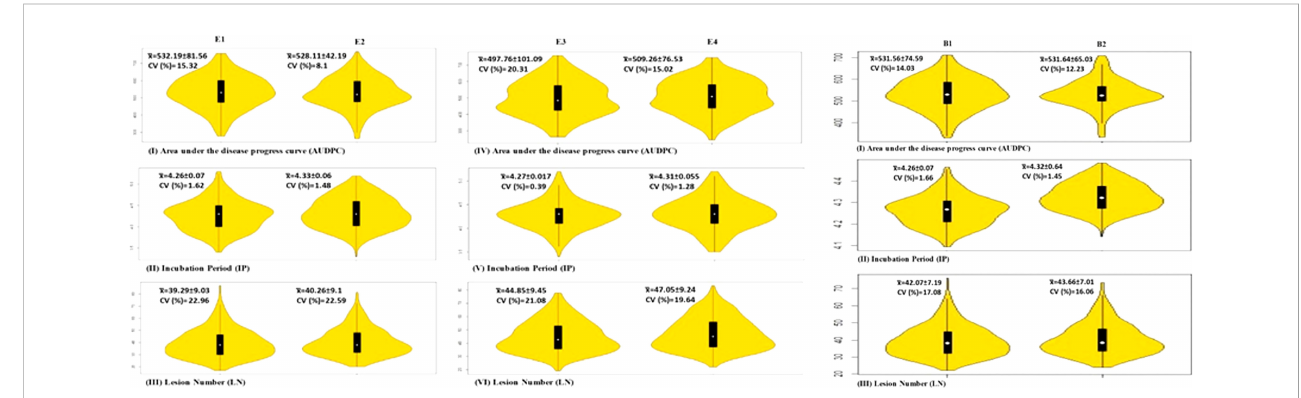
FIGURE 1 Violin plots for three traits in four environments and BLUP; means are shown by vertical solid black bars with means shown as white dots within the